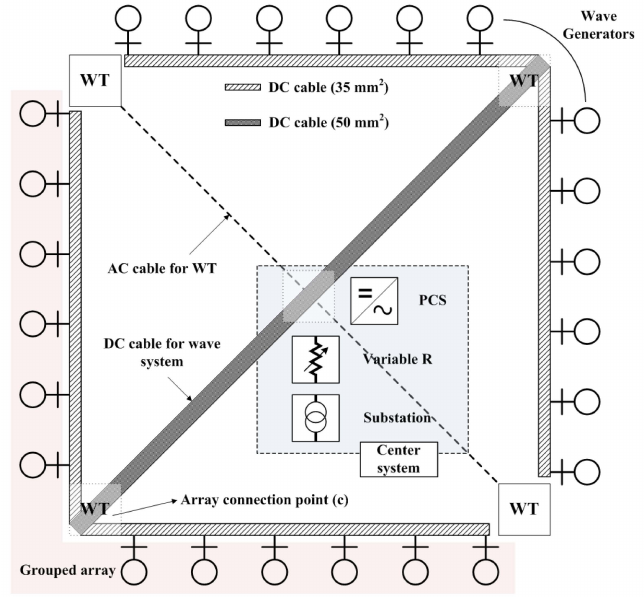
Figure 4. Electrical system structure of hybrid generation system